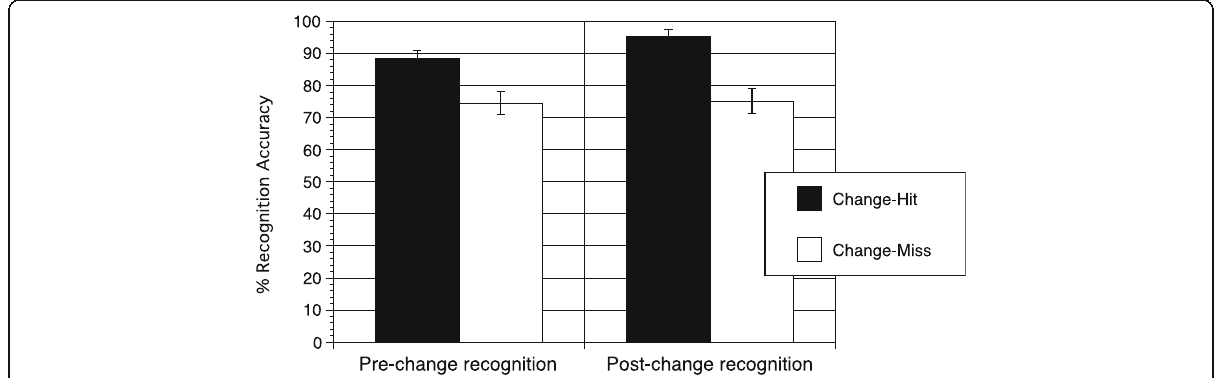
Fig. 1 Percent accuracy on visual recognition for change-hit and change-miss trials. Error bars represent standard